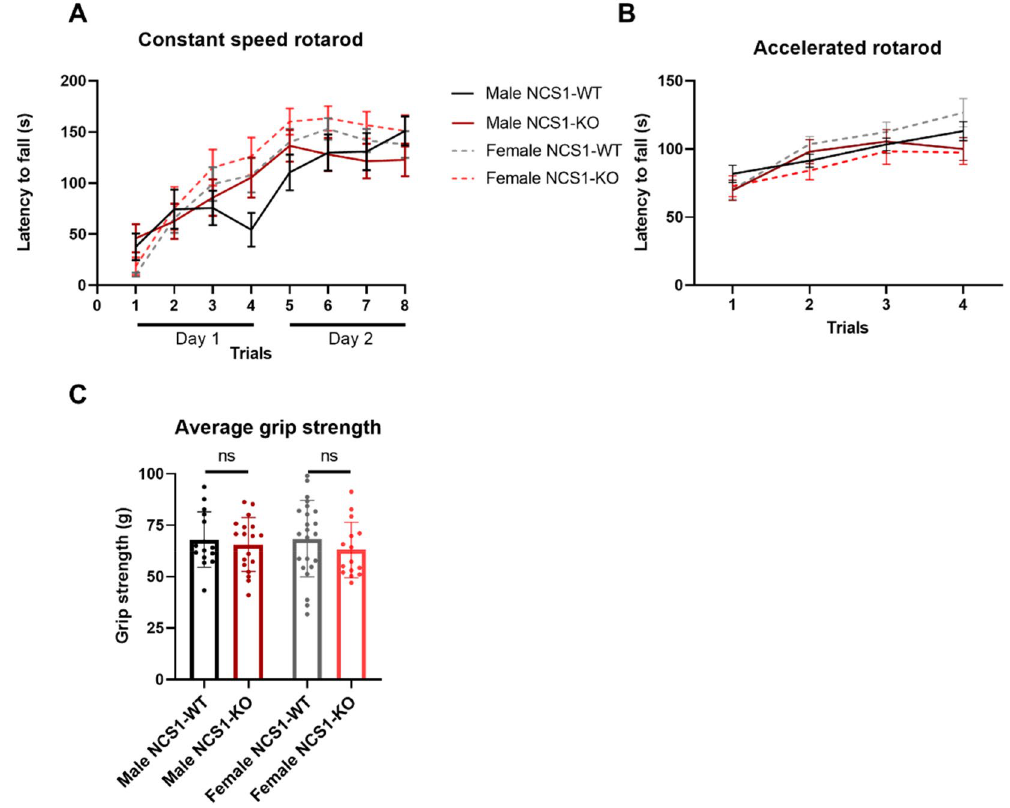
Figure 4. NCS1-WT and -KO mice perform similarly on motor tasks. ( A ) Although mice in all groups improved over time in the constant speed rotarod task [2-way ANOVA (male), Factor trial, p < 0.0001; 2-way ANOVA (female), Factor time, p < 0.0001], no differences were found between groups [2-way ANOVA (male), Factor genotype, p = 0.73; 2-way ANOVA (female), Factor genotype, p = 0.31]. ( B ) Similar results were found in the accelerated rotarod test [2-way ANOVA (male), factor genotype, p = 0.57; 2-way ANOVA (female), Factor genotype, p = 0.07]. ( C ) No differences were found in grip strength between male NCS1-WT and NCS1-KO mice (unpaired t-test, p = 0.61), or between female NCS1-WT and NCS1-KO mice (unpaired t-test, p = 0.33). Line graphs show mean ± SEM, bar graphs show mean ± SD For constant speed rotarod and grip strength. For grip strength and constant speed rotarod, male NCS1-WT: n = 15, male NCS1-KO: n = 18, female NCS1-WT: n = 15, female NCS1-KO: n = 23. For accelerated rotarod, male NCS1-WT: n = 13, male NCS1-KO: n = 13, female NCS1-WT: n = 9, female NCS1-KO: n =